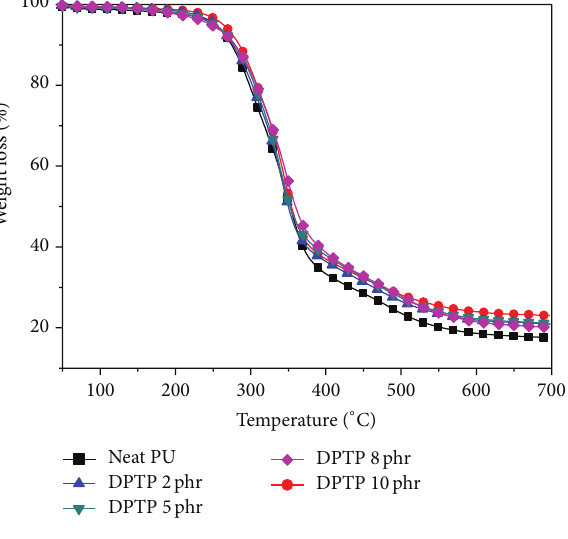
Figure 4: TGA curve of RPUF.